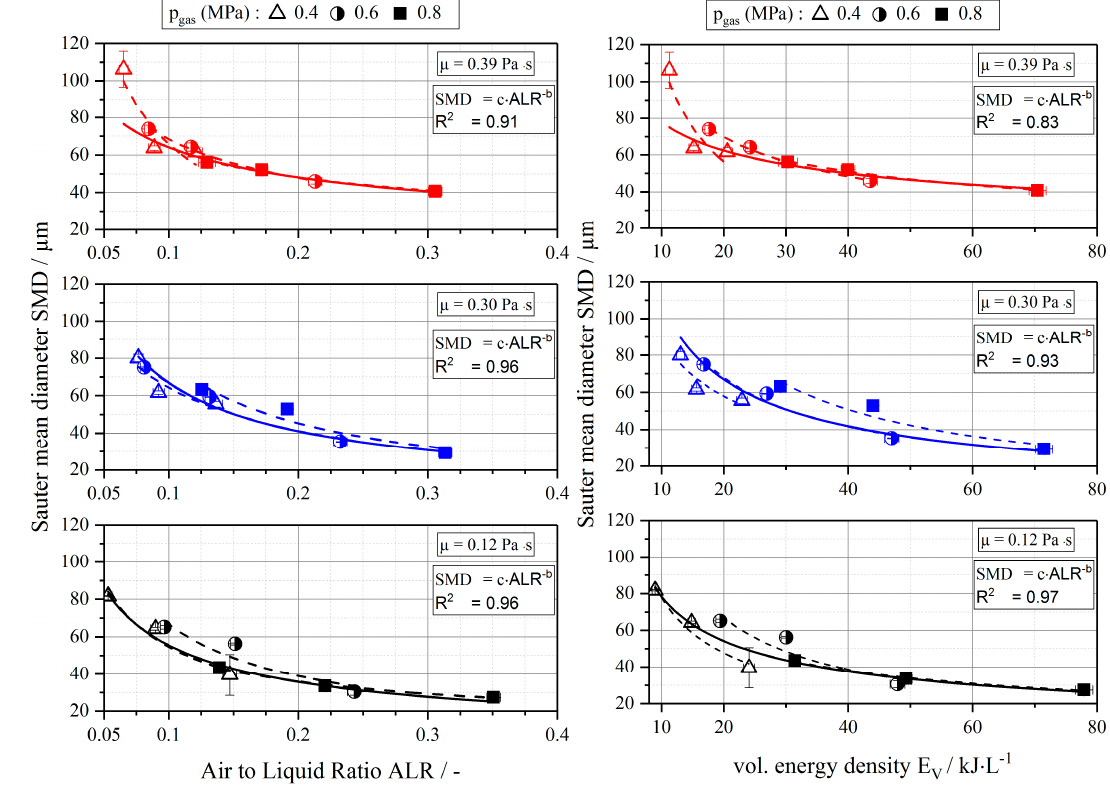
Figure 3. Characteristic droplet size Sauter mean diameter (SMD) in dependence of ALR (left) and volumetric energy density ( E V ) (right) for viscosities (µ) of 0.12 Pa ∙ s (black), 0.30 Pa ∙ s (blue), and 0.39 Pa ∙ s (red) at p gas of 0.4 MPa (empty triangles), 0.6 MPa (half-filled circles), and 0.8 MPa (filled squares). Additionally, fits of results at the same µ and same p gas are depicted by dashed lines. Total fits of all results at the same µ and different p gas are depicted by solid lines.